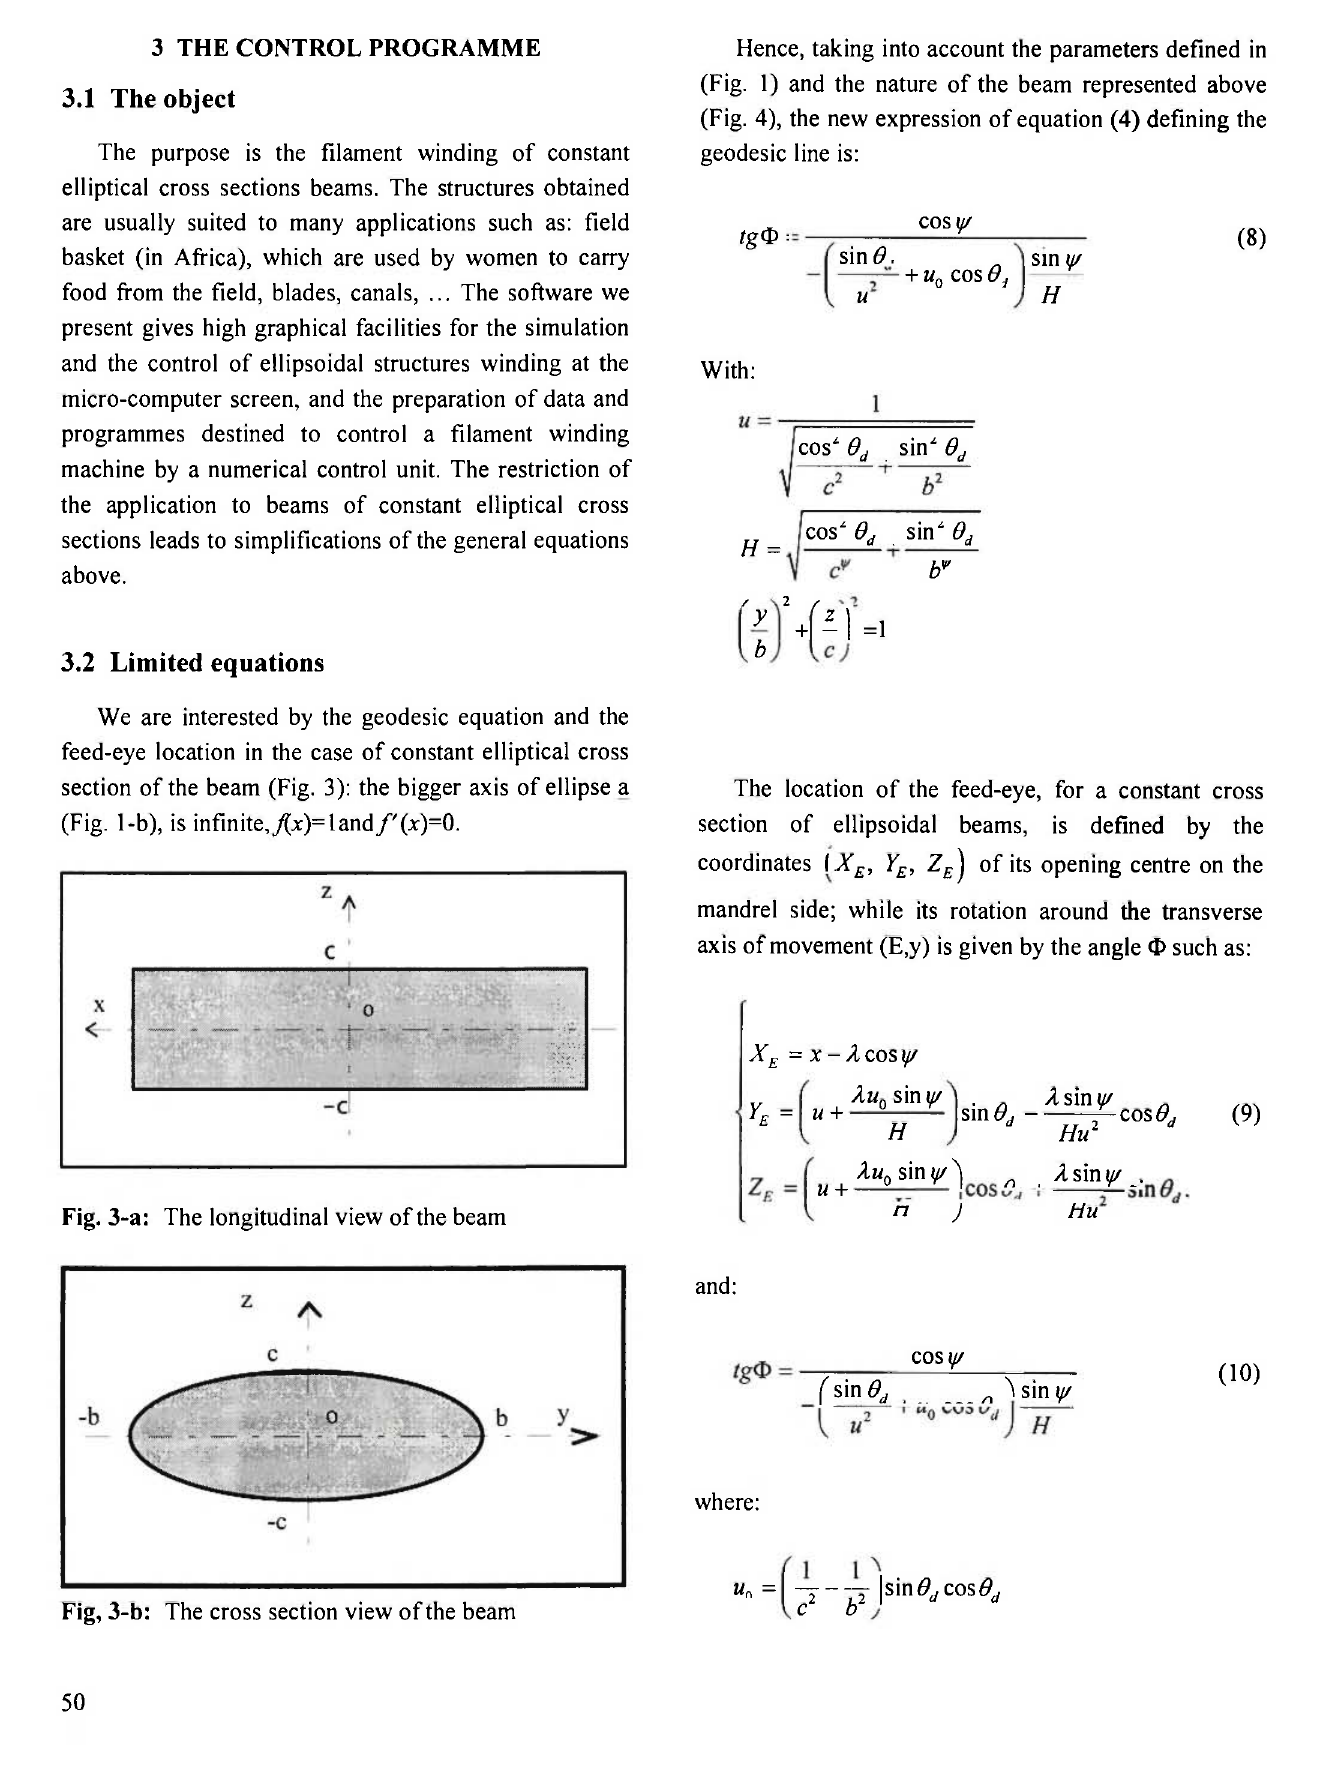
Fig, 3-b: The cross section view of the beam